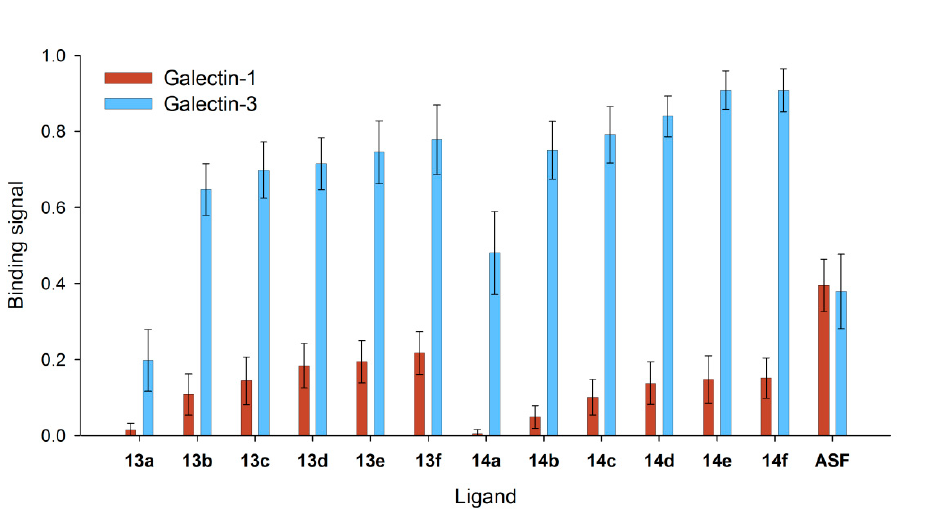
Figure 3. Comparison of Gal-1 and Gal-3 binding to immobilized neo-glycoproteins. In the ELISA-type assay, binding of 1 µM Gal-1 ( ■ ) and Gal-3 ( ■ ) to neo-glycoproteins 13a – f and 14a – f and to asialofetuin (ASF) as the control was measured. Signals showed different binding signals of both galectins to BSA decorated with C6-biotinylated